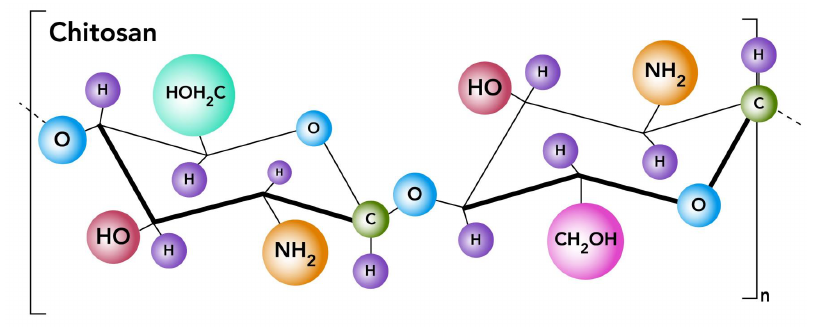
Figure 5. Chitosan molecular